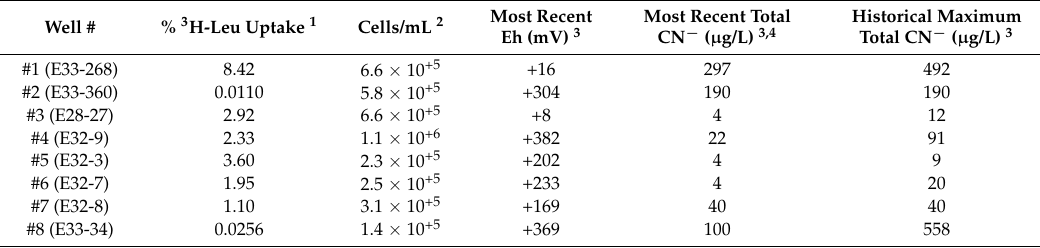
Table 2. Tritiated leucine uptake and microbial cell density observed in the wells examined, along with recent Eh values, recent total cyanide values, and historical maximum cyanide. Values for most recent pH ranged from 7.6 to 8.1 (see Table